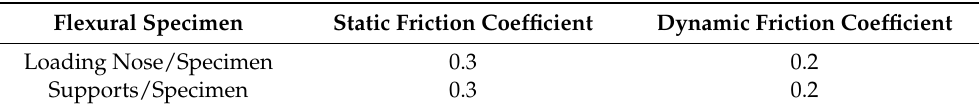
Table 4. Friction Coefficients.